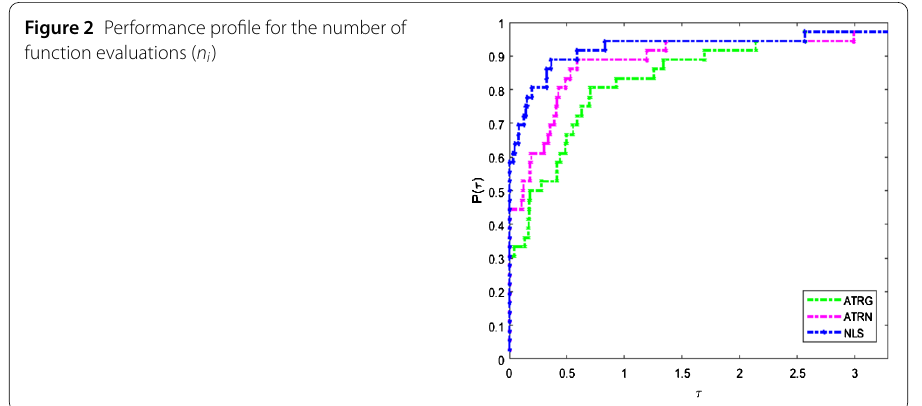
Figure 2 Performance profile for the number of function evaluations ( n i )